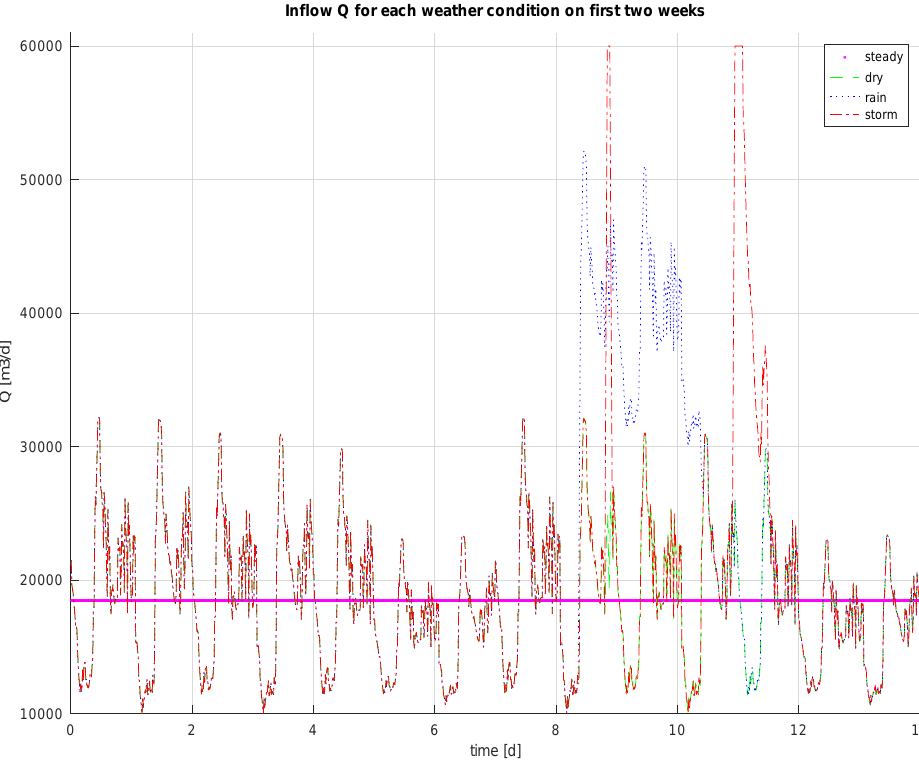
Figure 1. Different weather conditions in the influent defined in BSM1: dry (yellow), rain (blue) and storm